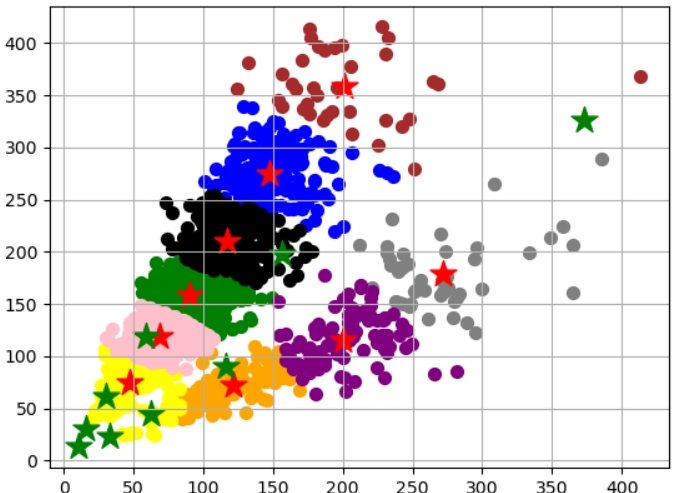
Figure 5. Clustering results of anchor boxes. The red pentagrams in the figure are the anchor frame scales after clustering, while the green pentagrams represent the anchor frame scales before